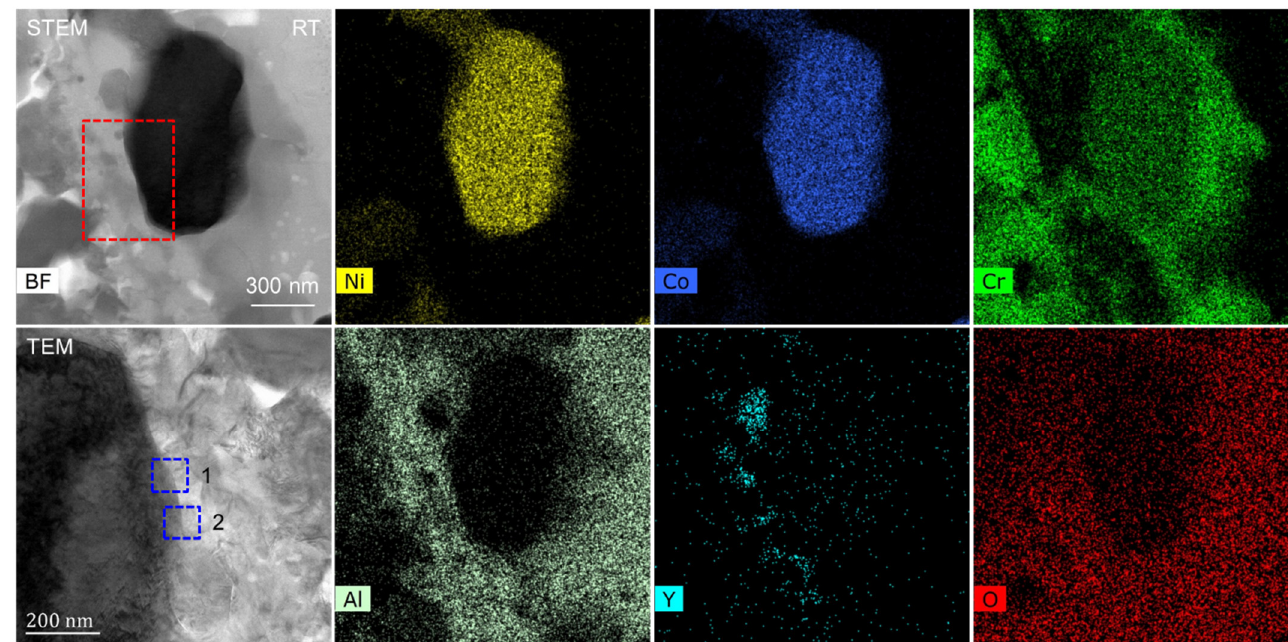
Figure 8. Morphology of TC/TGO interface at different temperatures.